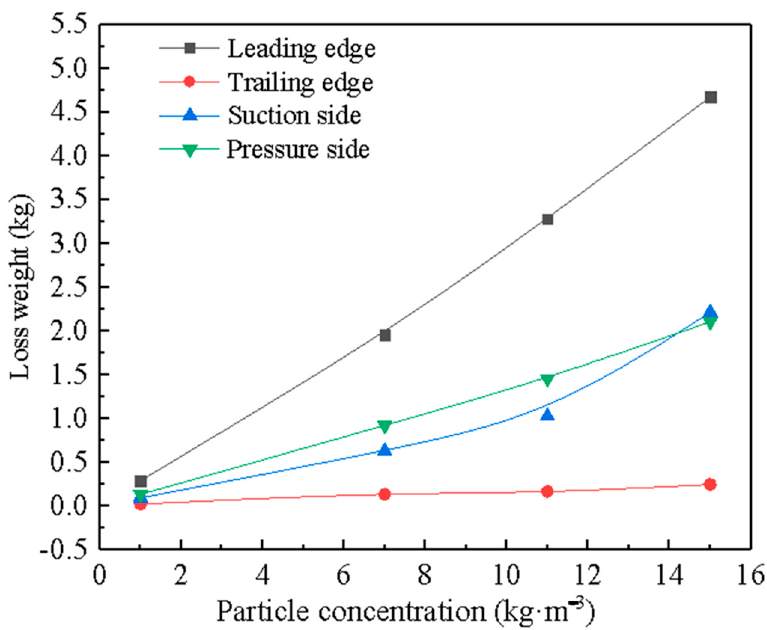
Figure 20. Change curve of erosion mass loss of single blade with different particle concentration.